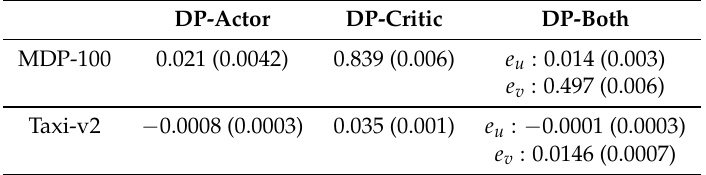
Table 4. Mean (Variance) of cosine similarity between non-DP and each cases.